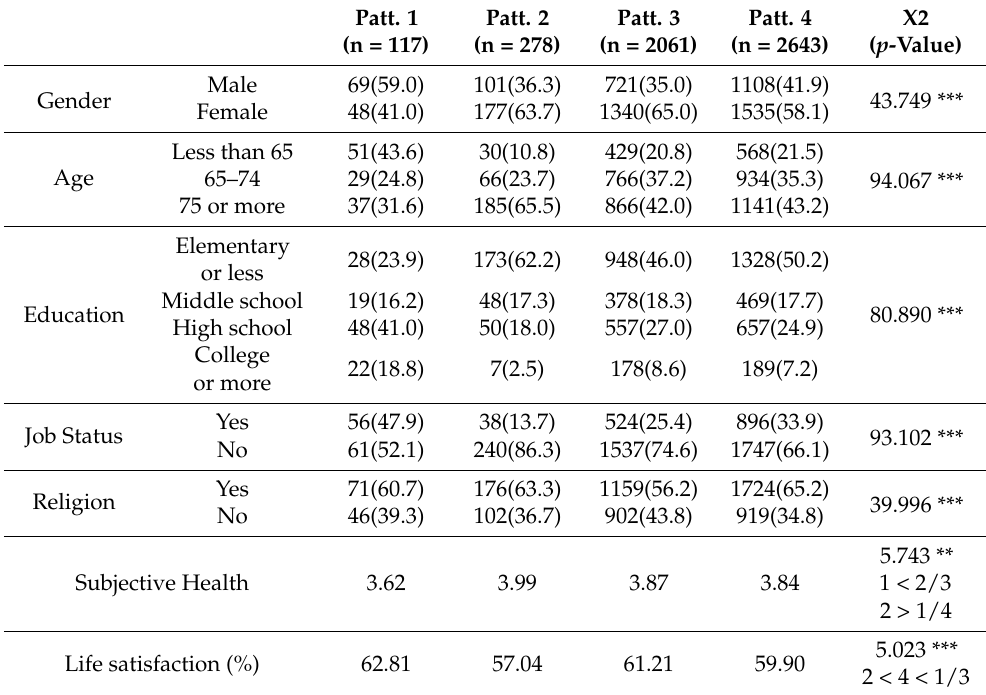
Table 3. Sociodemographic Factors in Each